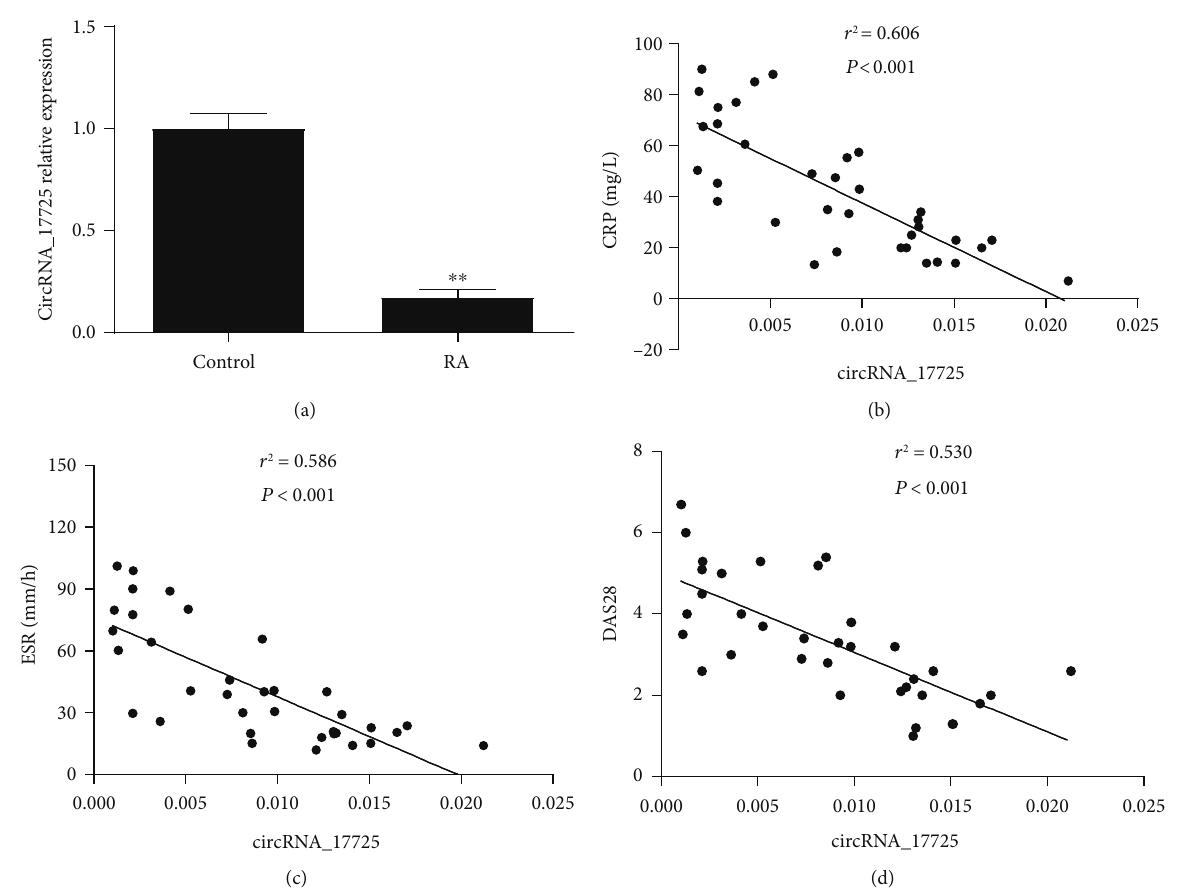
Figure 1: Expression of circRNA_17725 in the PBMCs and its association with the disease activity indexes of RA. (a) Expression of circRNA_17725 in the PBMCs from RA patients ( ∗∗ P < 0 : 01 ; RA/control: 35/28). (b) Pearson ’ s correlation analysis: relationship of circRNA_17725 with CRP ( n = 35 ). (c) Pearson ’ s correlation analysis: relationship of circRNA_17725 with ESR ( n = 35 ). (d) Pearson ’ s correlation analysis: relationship of circRNA_17725 with DAS28 ( n = 35